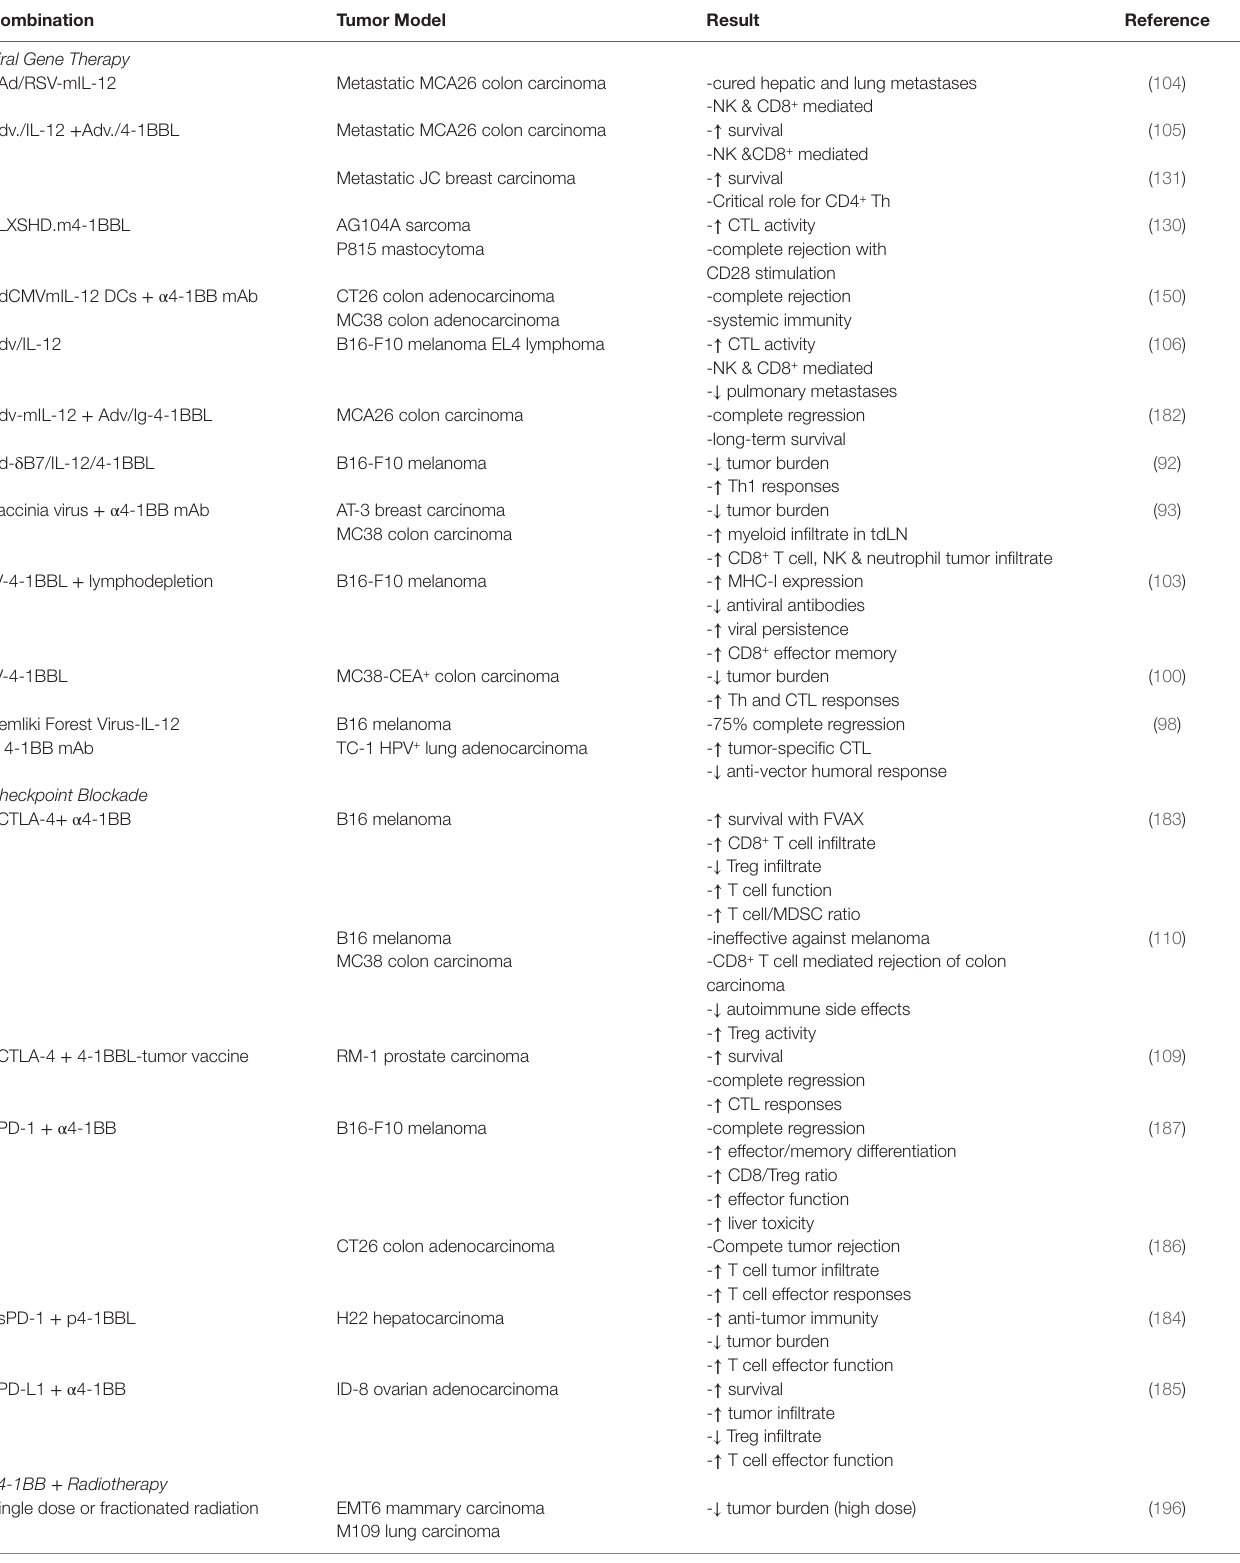
TABle 1 | Combinations with 4-1BB targeted therapies.